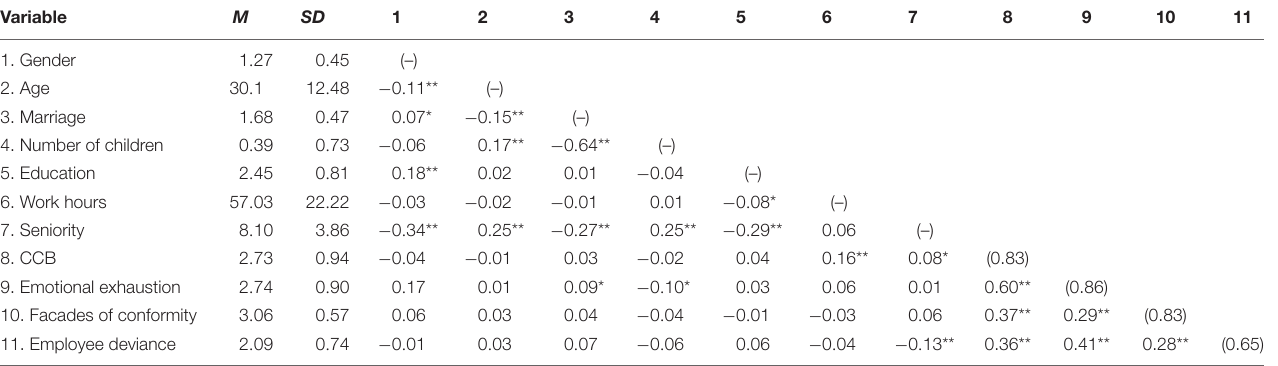
TABLE 2 | Means, standard deviations, Cronbach’s alpha, and intercorrelations among study. Variable M